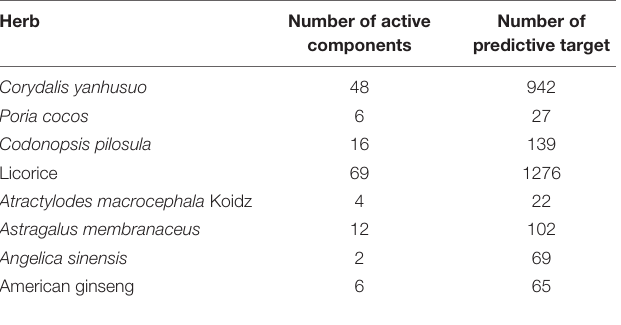
TABLE 1 | Information of “Herb-active component-predictive target” for candidate Chinese herbal medicine (CCHM). Herb Number of active